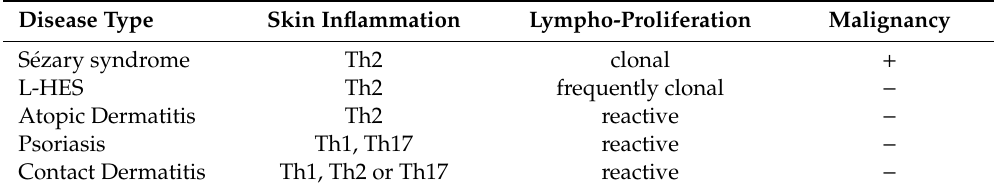
Table 1. Shared and distinct features of S é zary syndrome and disease controls. Disease Type Skin Inflammation Lympho-Proliferation